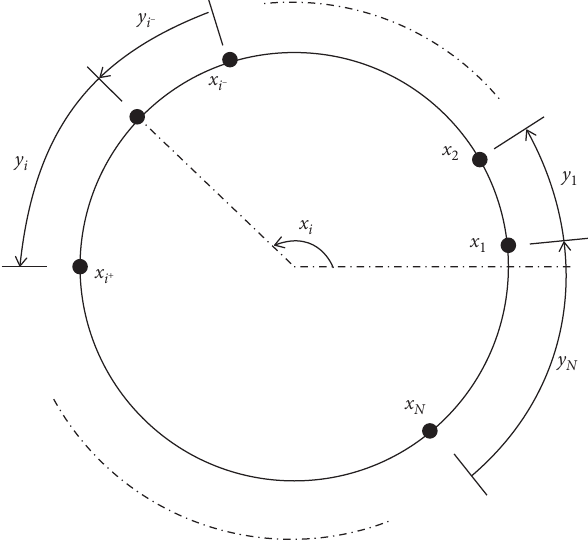
Figure 1: Agents distributed on a prescribed